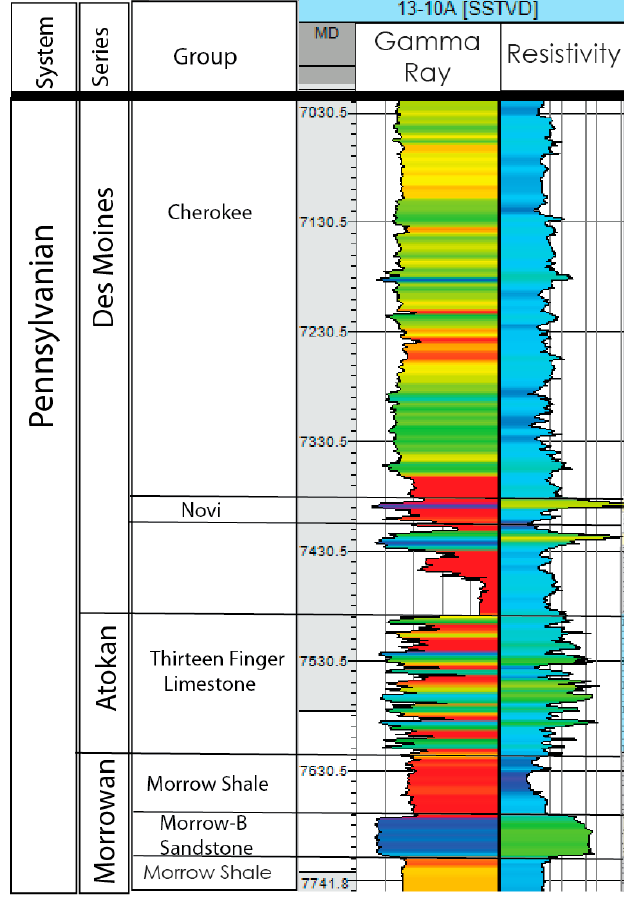
Figure 2. Stratigraphic column for Upper Morrow and Atokan intervals cored at FWU.